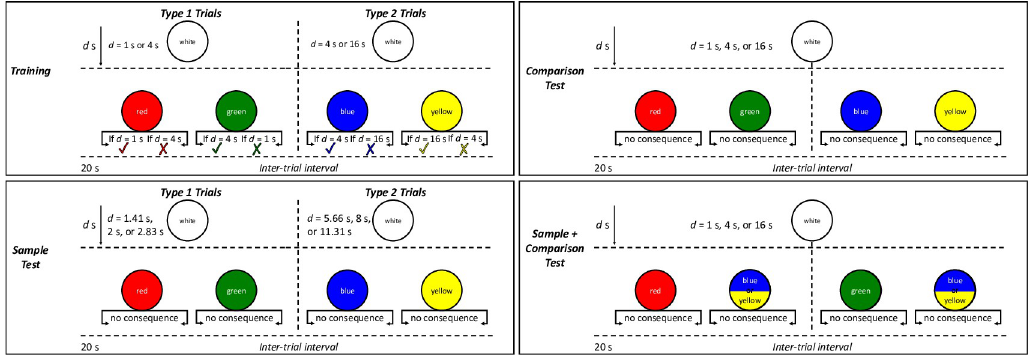
Fig 1. The double-bisection task. Note: Ticks denote correct choices, crosses incorrect. The durations and colors in the diagram are those used in the current study.